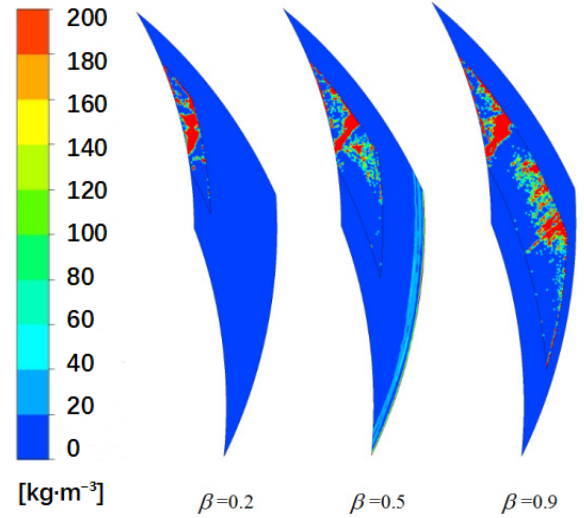
Figure 12. Particles’ distribution with different groove diameter ratios.